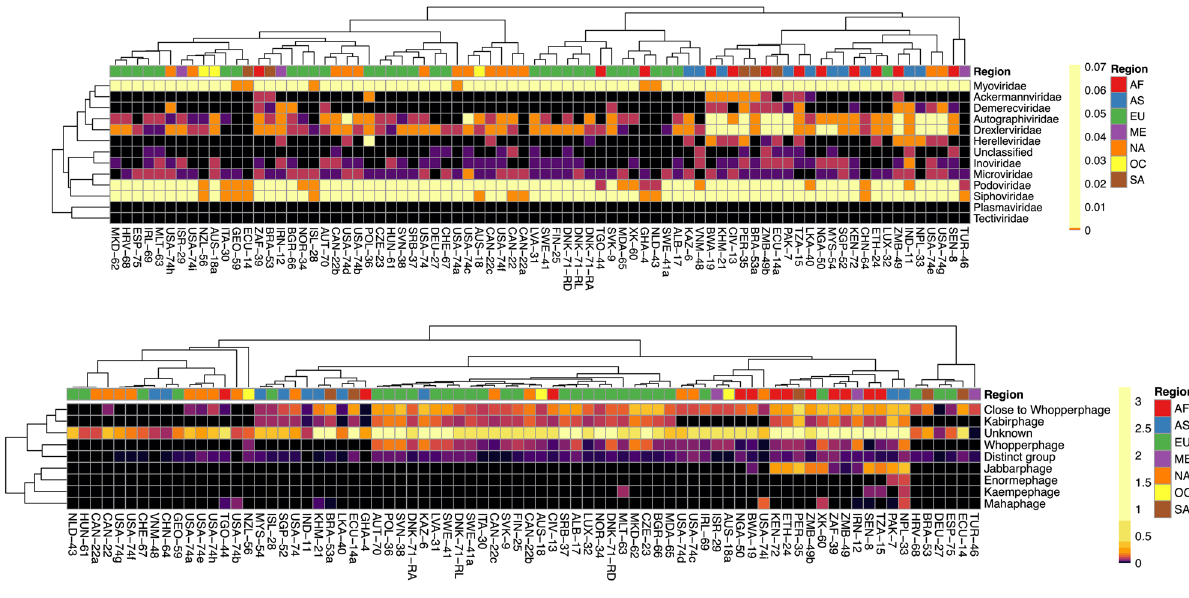
Figure 4. Pooled relative abundance of phages in their respective phage families (NCBI, top) and clades (huge phages, bottom). Intensities based on 10%- and 3.3%-quantiles, respectively. AF Africa, AS Asia, EU Europe, NA North America, ME Middle East, OC Oceania, SA South America.